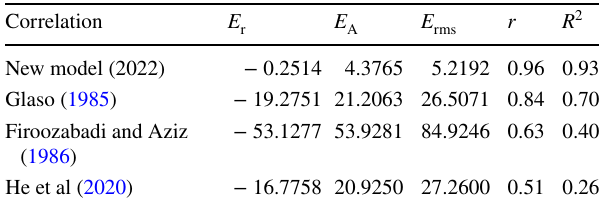
Fig. 2 Residual by predicted plot